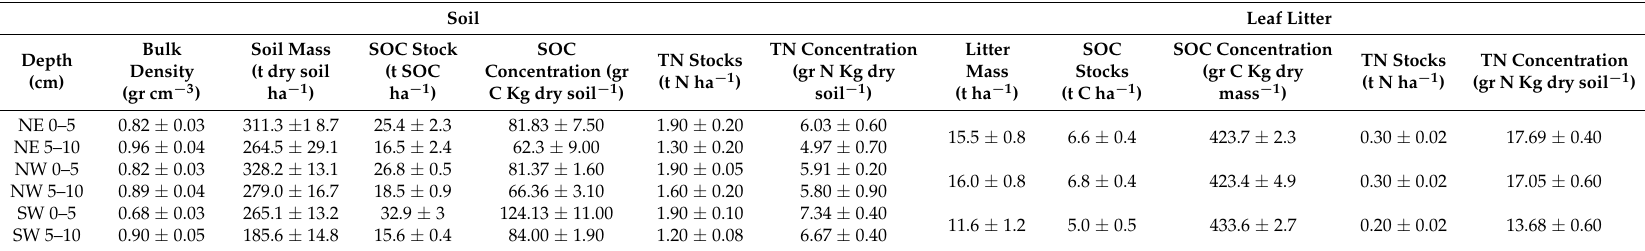
Table 1. Soil properties, soil organic carbon (SOC) and total nitrogen (TN) stocks in leaf litter and mineral soil of the investigated sites as affected by exposure and soil